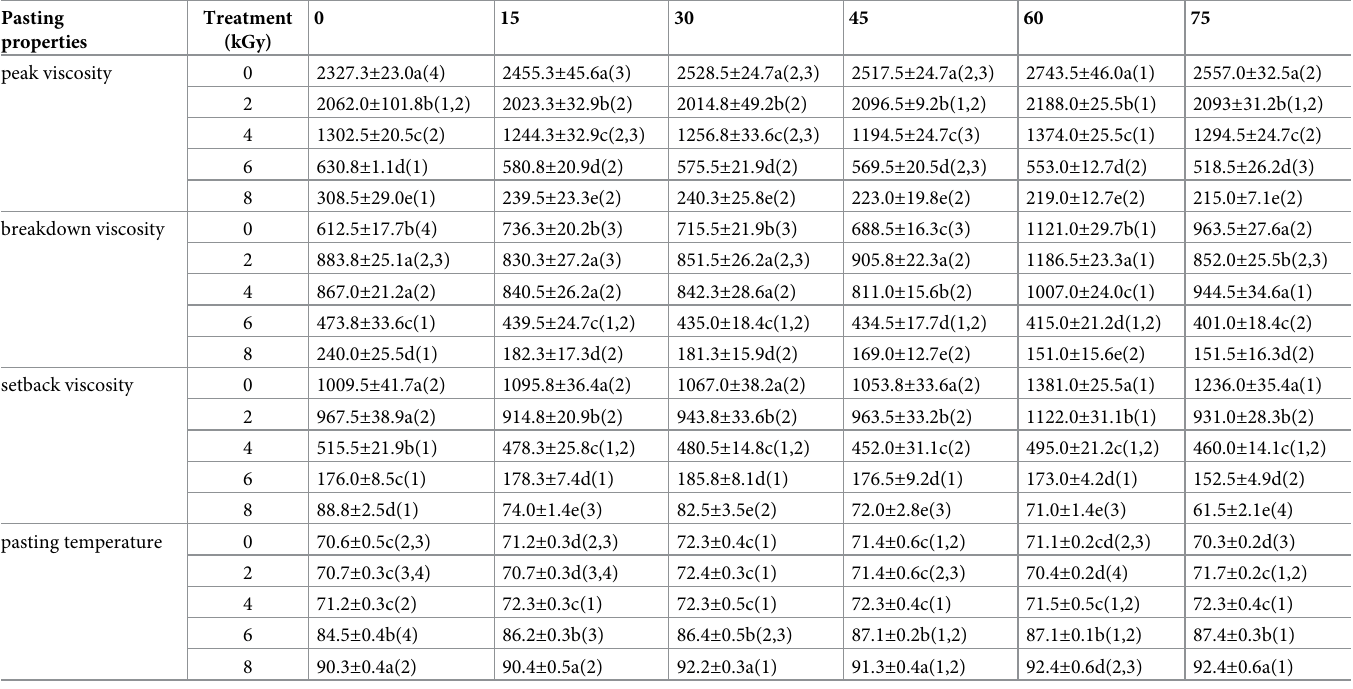
Table 1. Pasting properties of irradiated white rice flour during 75 days of storage at 25 ˚C. Pasting properties